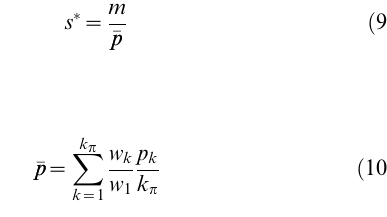
Figure 3. Migration load at the migration-selection balance. A – Comparison of the migration load ( L ) imposed by the introgression of 2 to 6 genes in the initial block, calculated from the Branching Process Approximation (BPA, green dots), Panmictic Simulation (PS, red dots), Introgressive Simulation (IS, blue dots) and Single Crossover Simulation (SCS, black dots). Parameter values are: S= 0.7, h =0.5, m =0.003, r =0.015, n =10. B – Migration load ( L ), calculated from the BPA, as a function of the length ( k p ) of the initial block. The curves (from bottom to top) correspond